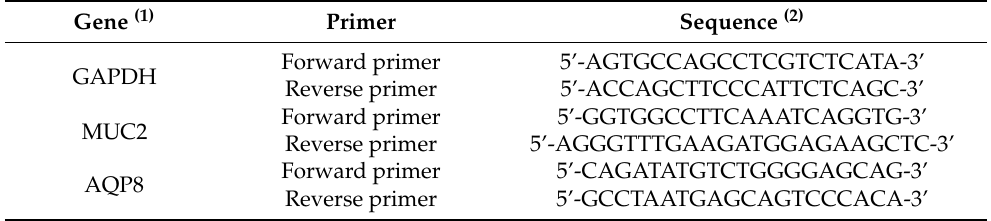
Table 1. Primer sequences of transcription factors used for real-time PCR